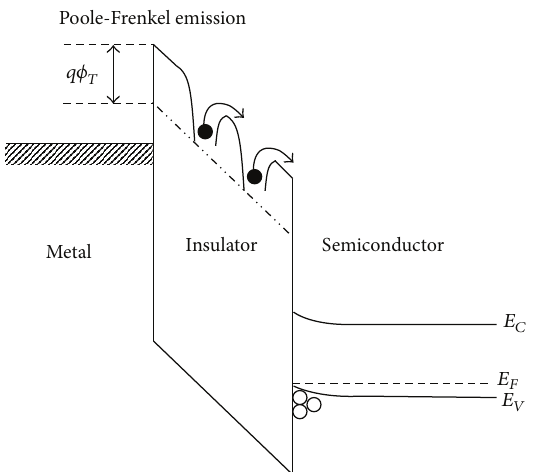
Figure 12: Characteristics of 𝐽 - 𝐸 plot and simulation of P-F emission for the laminated Pr 2 O 3 /SiON MIS capacitors at high